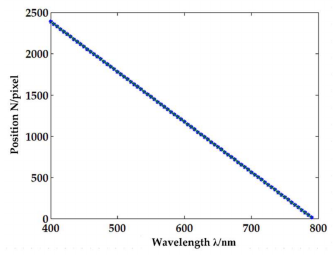
Figure 7. Relationship between pixel position N and wavelength λ for fiber